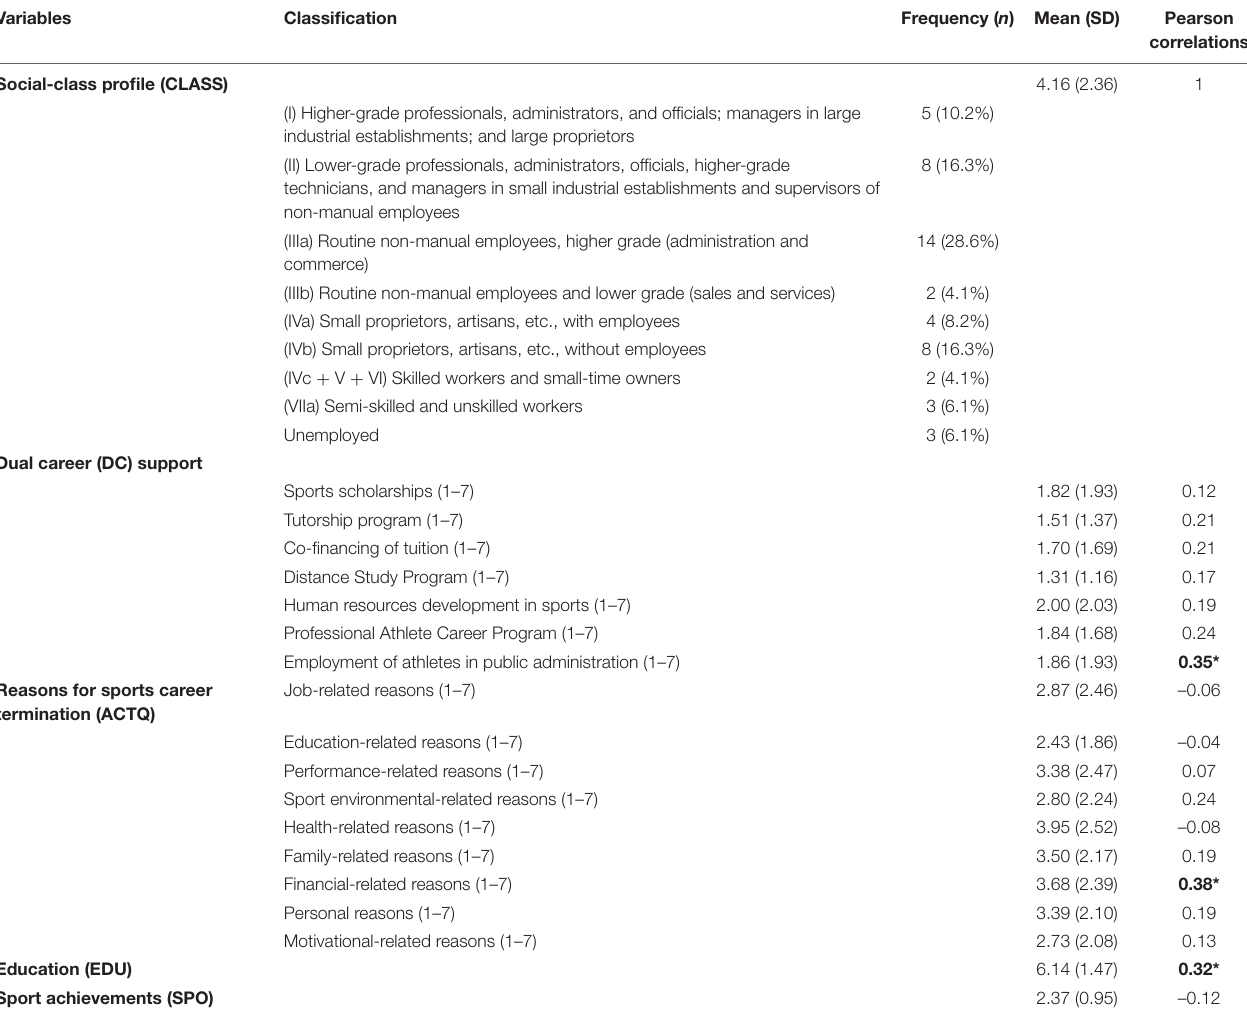
TABLE 2 | Descriptive statistics for variables and Pearson correlation coefficients (from the Pearson correlation